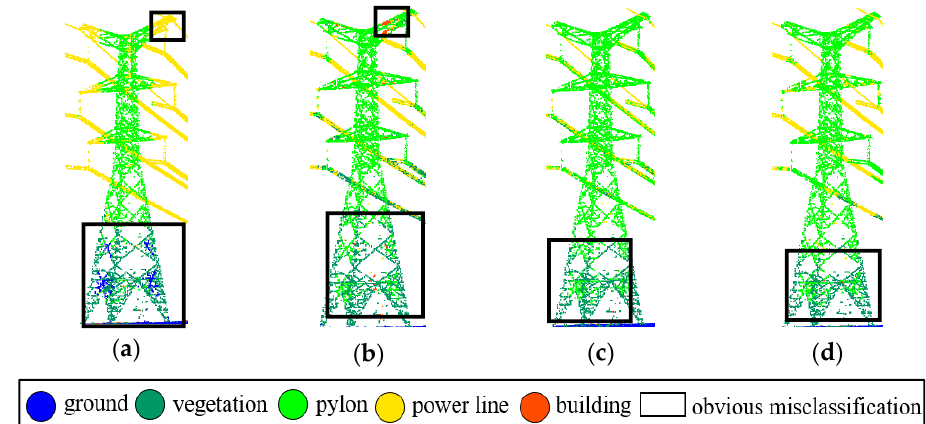
Figure 11. The classification results of pylon type-II with different classifiers( feature set = F 0 , class distribution = unbalanced, R = 1.5 m): ( a ) The pylon is colored by the KNN prediction results; ( b ) the pylon is colored by the LR prediction results; ( c ) the pylon is colored by the RF prediction results; ( d ) the pylon is colored by the GBDT prediction results.